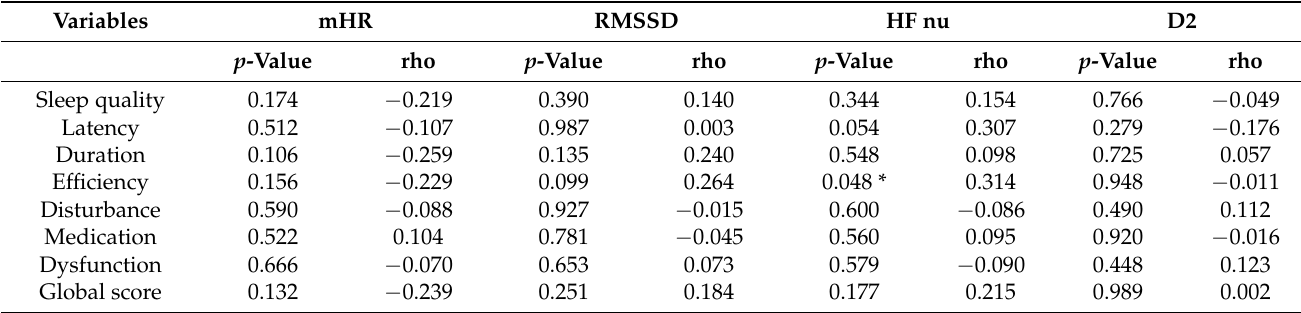
Table 3. Non-parametric Spearman’s partial correlation analysis between HRV and PSQI scores ( n = 42).